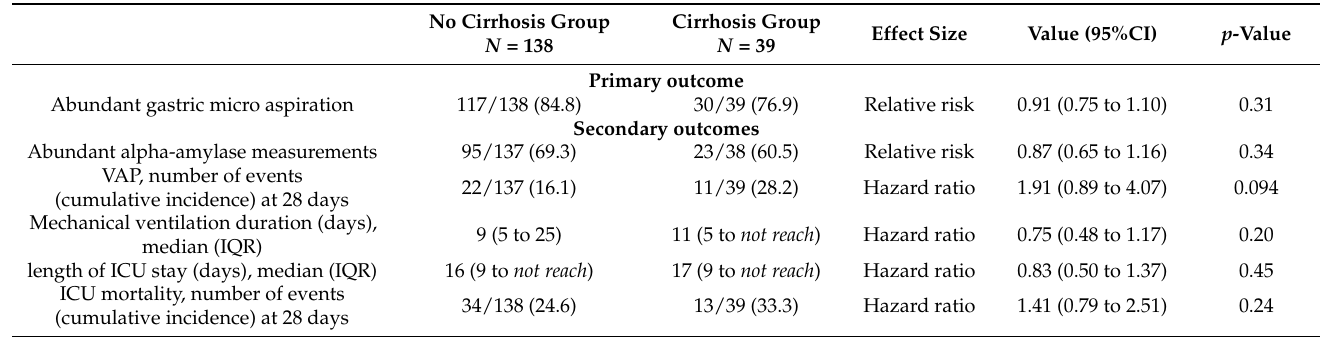
Table 3. Outcomes in patients with and without cirrhosis, after